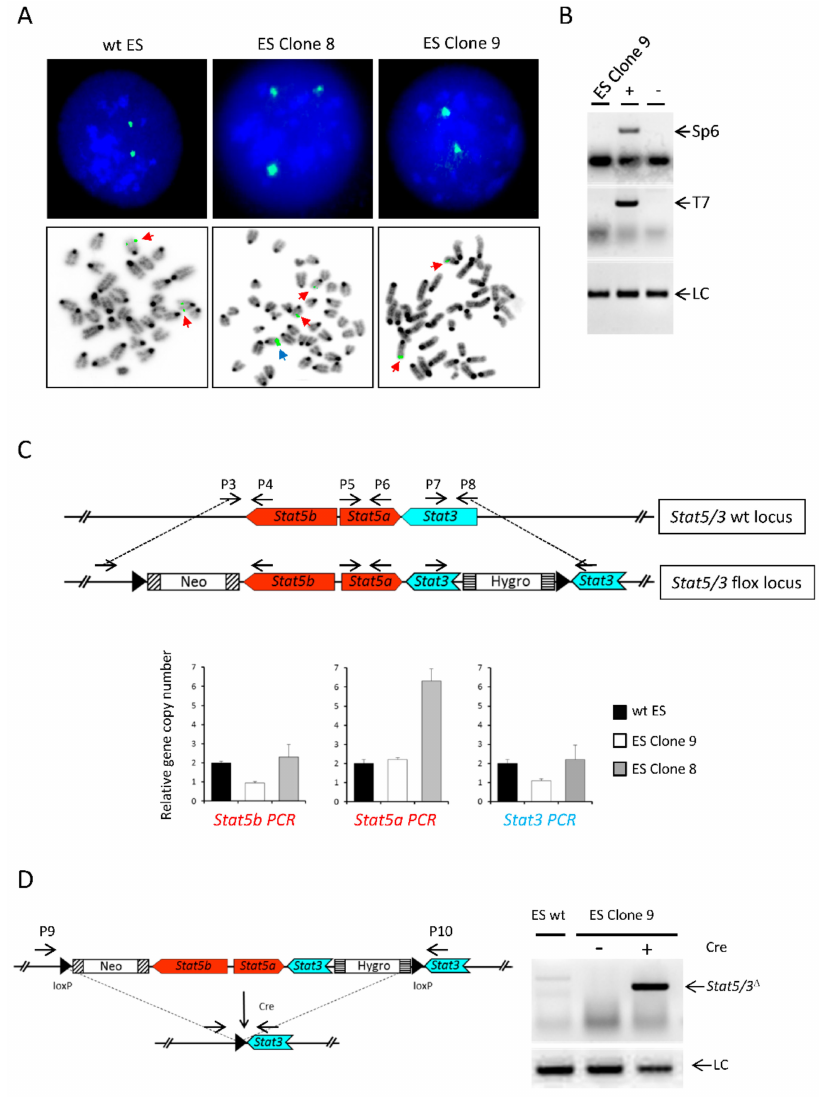
Figure 2. Identification of correctly targeted ES cells. ( A ) FISH analysis of wt ES cells and clones 8